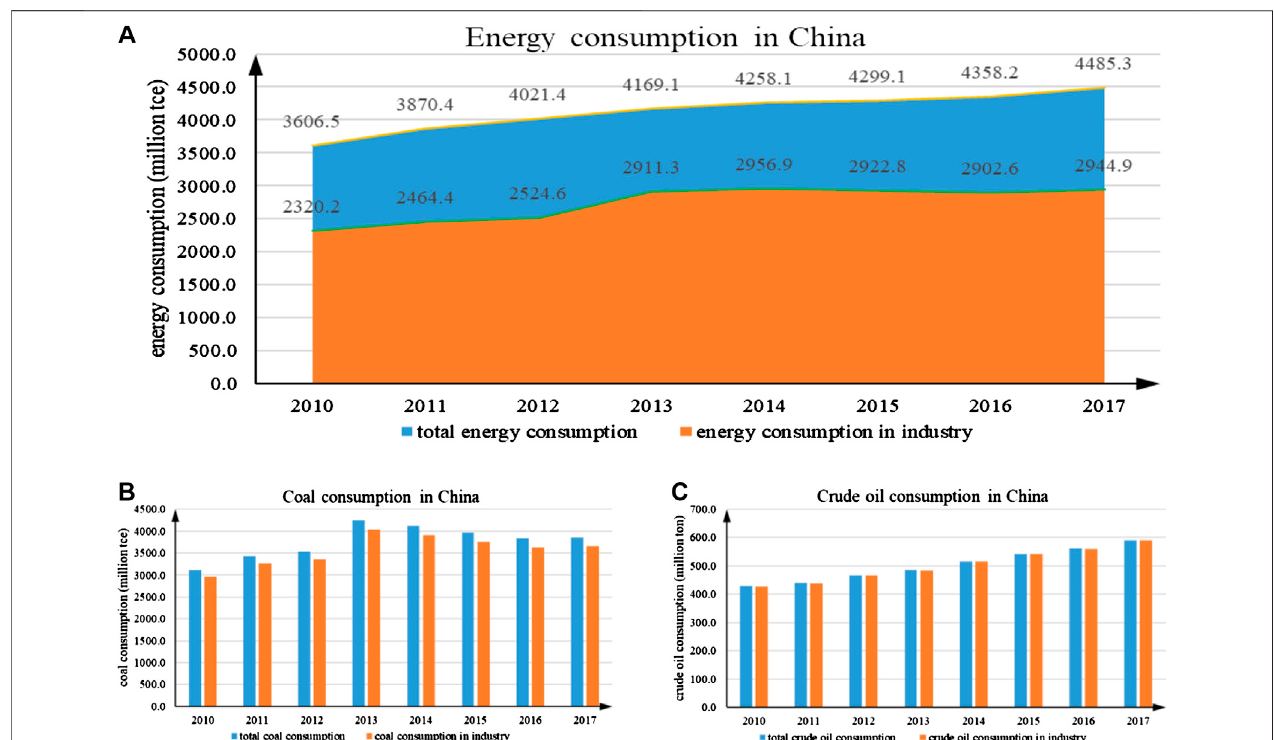
FIGURE 1 | The total and main energy consumption in